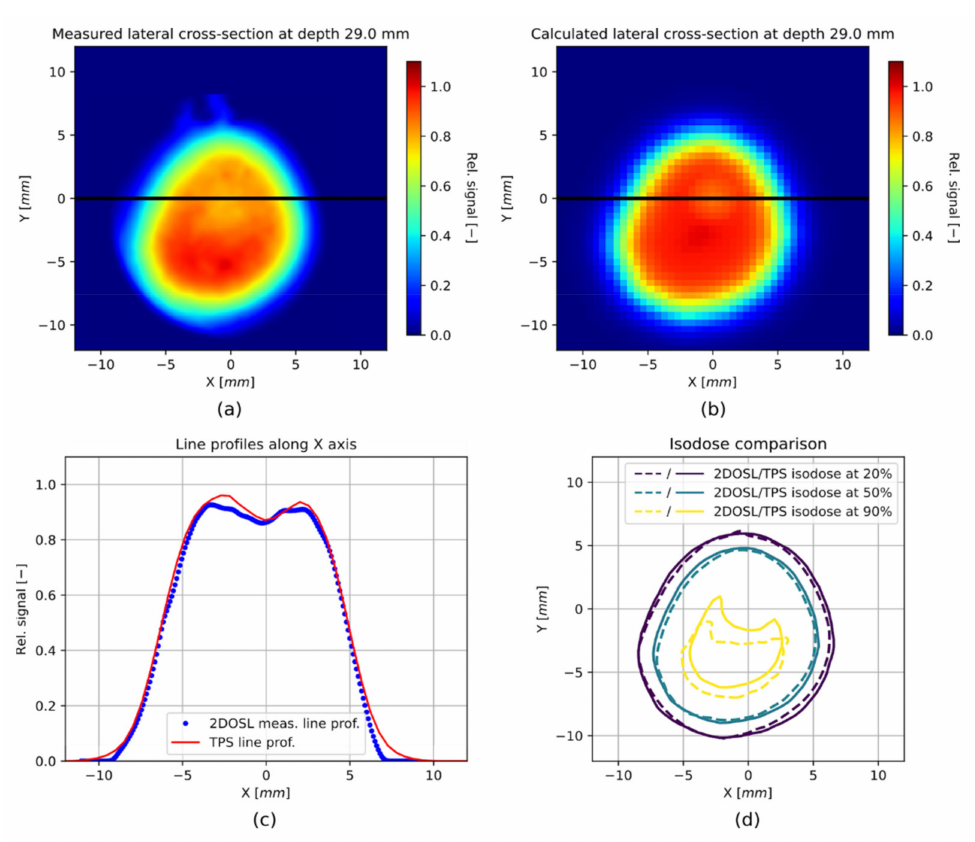
Figure 13. ( a ) Lateral cross-sections extracted from the 3D relative dose image measured with the stack of 2D LMP foils; ( b ) Lateral cross-sections from 3D relative dose image calculated by the TPS at depth 29 mm (range of the SOBP at 90% of the distal fall-off), both normalized to the maximum value of the cross-section; ( c ) A comparison of line profiles along the X axis; ( d ) A comparison of isodoses at 20%, 50% and 90% of the maximum value of the